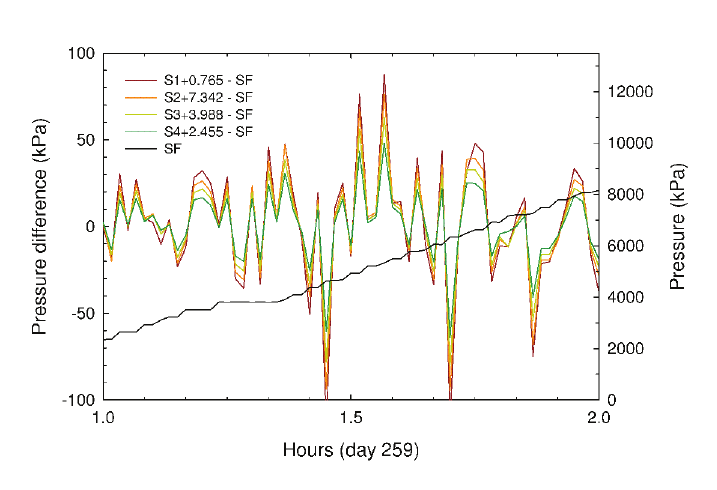
Figure 4. Pressure variations measured during the decent of the ACORK system. Screen pressures are shown relative to the seafloor sensor pressure (scale on left). Offsets given in legend are applied in this and other figures. Absolute pressure is shown for the seafloor sensor (scale on right). Units used for differential and absolute pressure in this and other plots are kPa, equivalent to a seawater head of 0.1